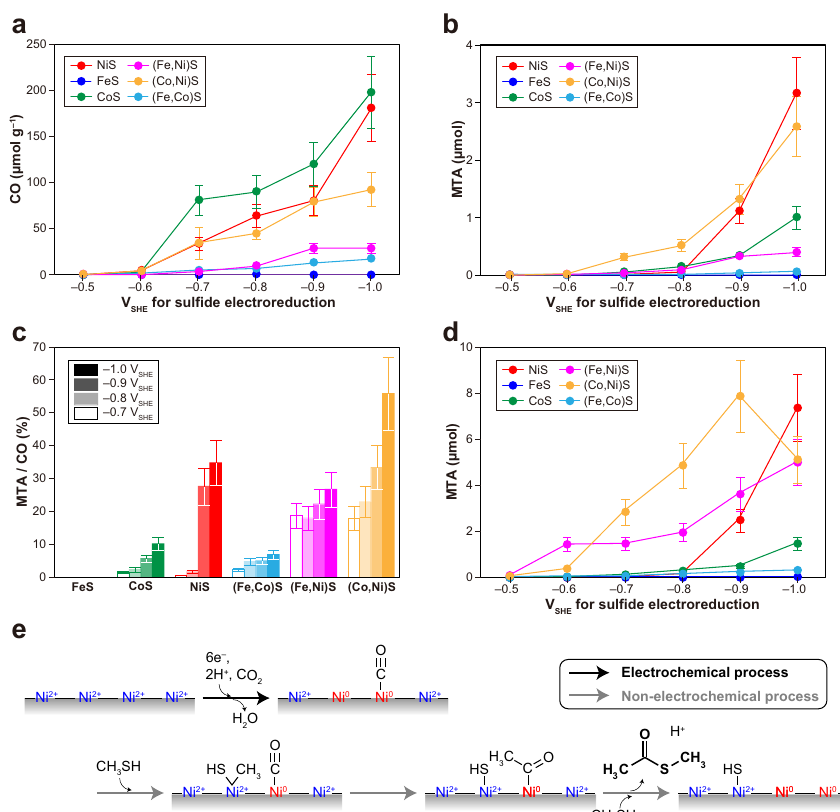
Fig. 2 CO 2 -to-CO electroreduction and CO conversion to S-methyl thioacetate (MTA) on the metal-sul fi de_PERMs. a The amounts of surface-bound CO on the electrolyzed sul fi des ( μ mol g − 1 ). b The yields of MTA from the surface-bound CO ( a ) in the presence of methanethiol (75 μ mol per 50 mg of sul fi de). c The percentages of CO converted to MTA in the reactions shown in ( b ). d The yields of MTA from externally added CO and methanethiol (75 μ mol for each). The MTA yield on (Co,Ni)S declined at the lowest potential ( – 1.0 V SHE ) because of the depletion of methanethiol (see Supplementary Table 4). e Possible intermediate steps in the MTA synthesis via the formation of NiS_PERM with the surface-bound CO (red arrow) and the CO- methanethiol reaction on NiS_PERM (green arrows). The error bars in a – d were determined by multiple independent runs under the same reaction conditions (see “ Methods ”